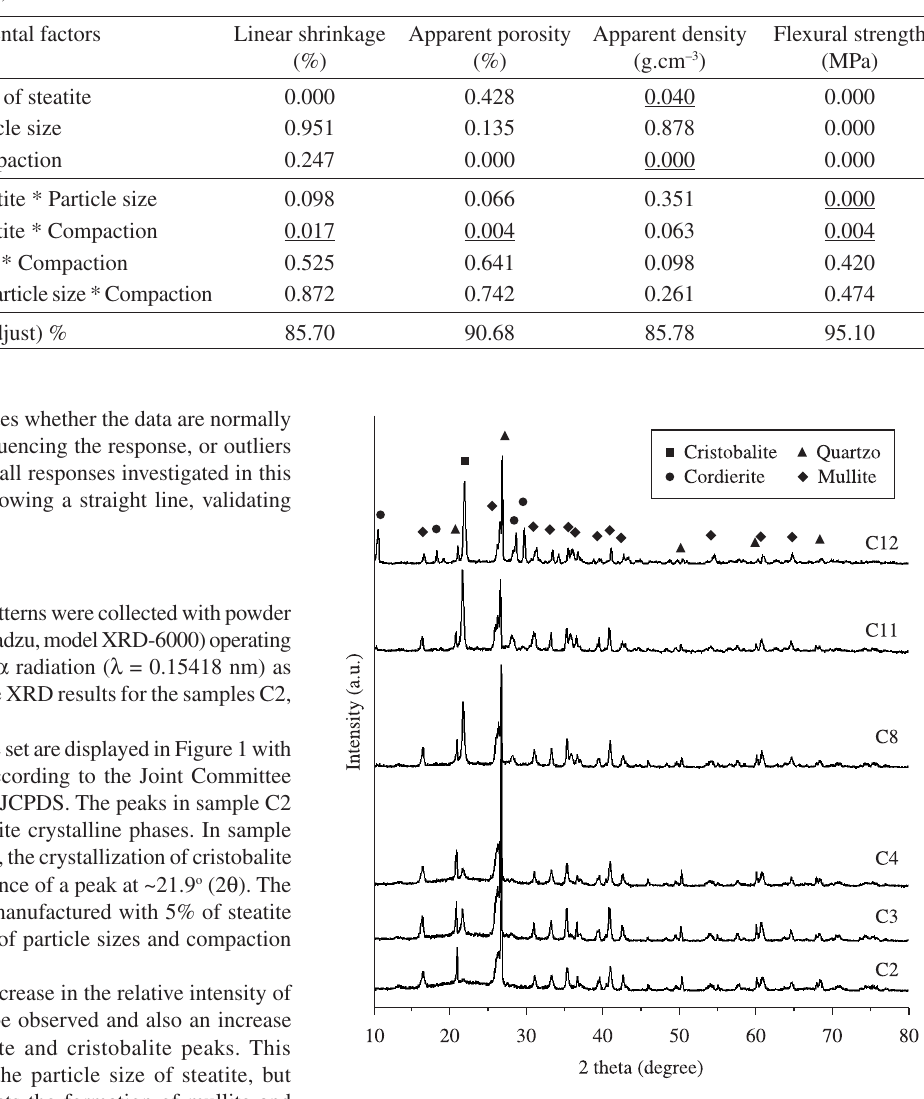
Figure 1. X-ray diffractometer